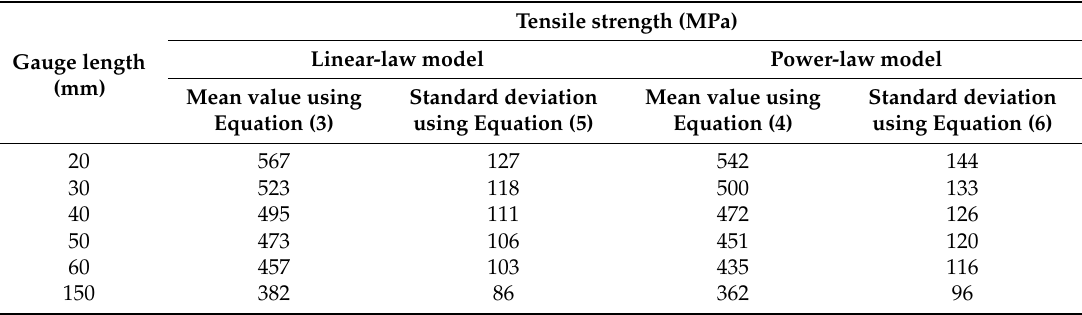
Table 4. Predicted fiber strength and its variability using Weibull distribution.